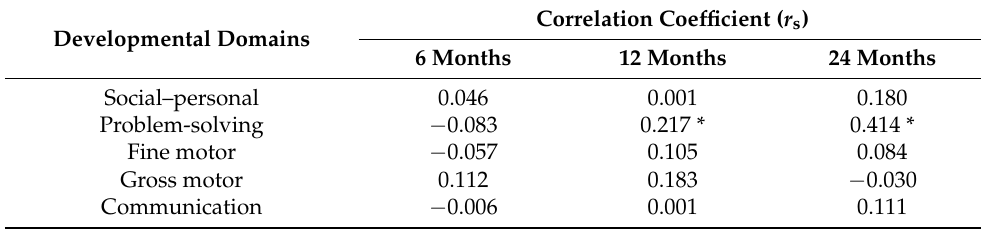
Table 4. Correlation between newborn vitamin D levels and infant